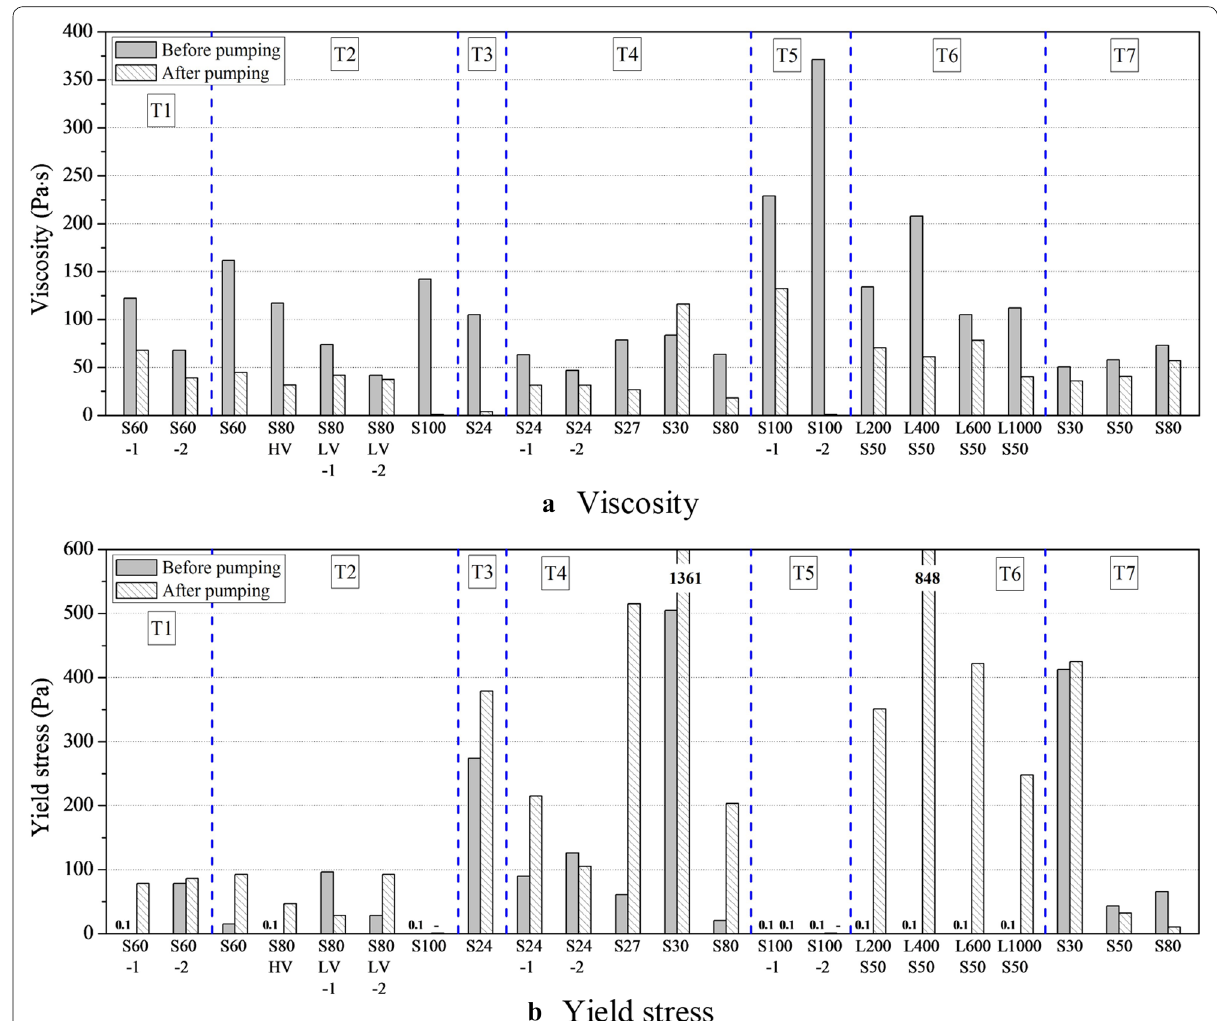
Fig. 3 Results of rheological property from the real-scale pumping